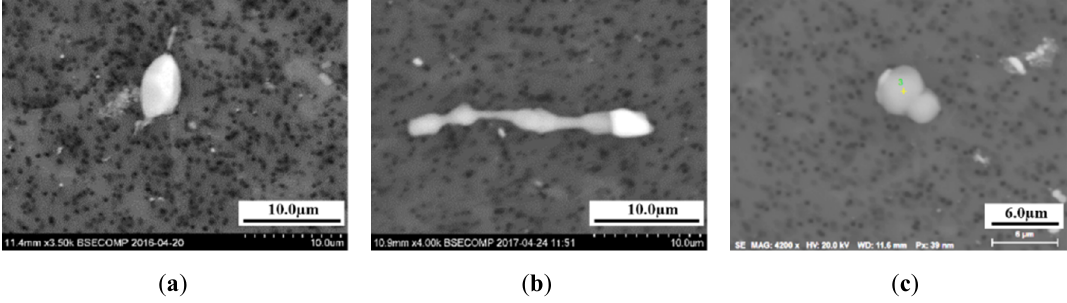
Figure 8. Typical non-metallic inclusions (NMI) investigated by using scanning electron microscope (SEM) after electrolytic extraction: undeformable oxides ( a ), elongated oxides ( b ) in 316L + Ca steel, and undeformed oxides ( c ) in 316L steel.